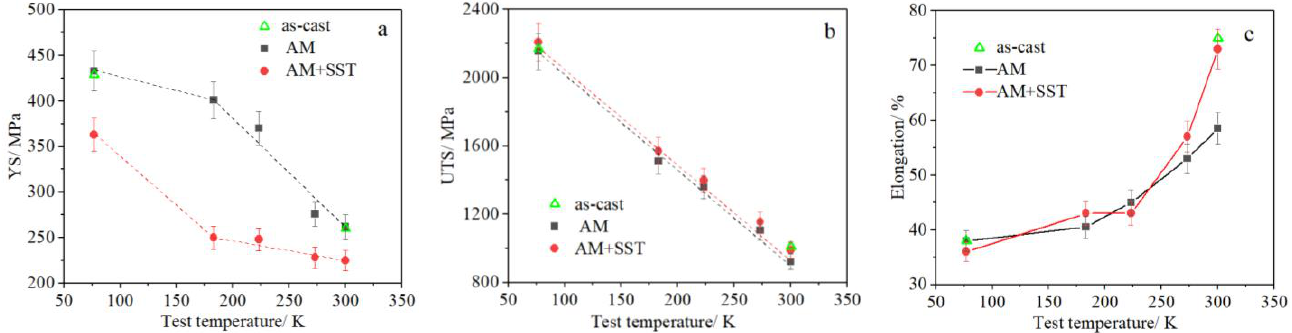
Figure 4. The temperature dependencies of the yield strength (YS) ( a ), the ultimate tensile strength (UTS, estimated using true diagrams) ( b ) and elongation-to-failure (total elongation estimated using engineering diagrams) ( c ) for the AM, the AM + SST and the as-cast samples.